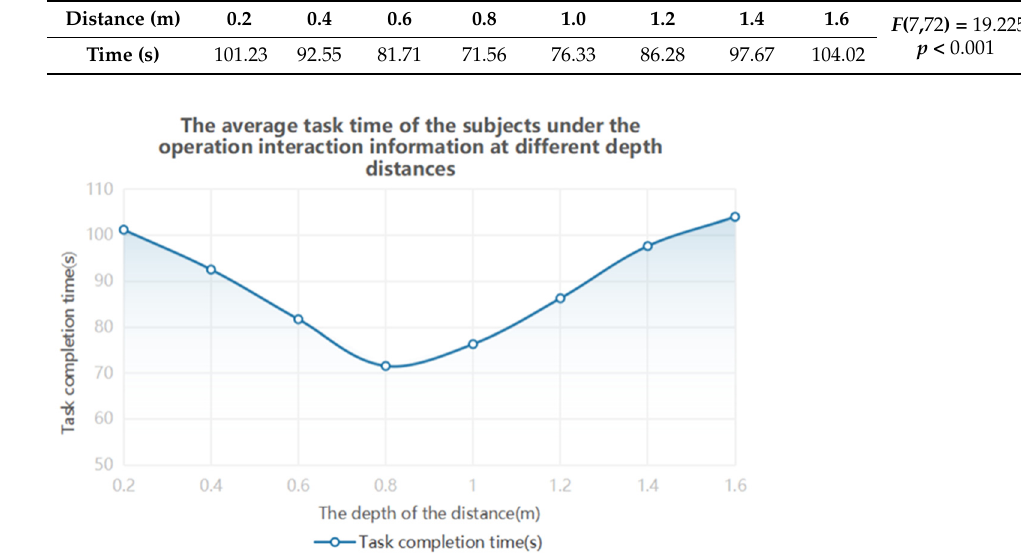
Figure 6. Time variation trend of operation interaction information to complete tasks at different depths and distances.